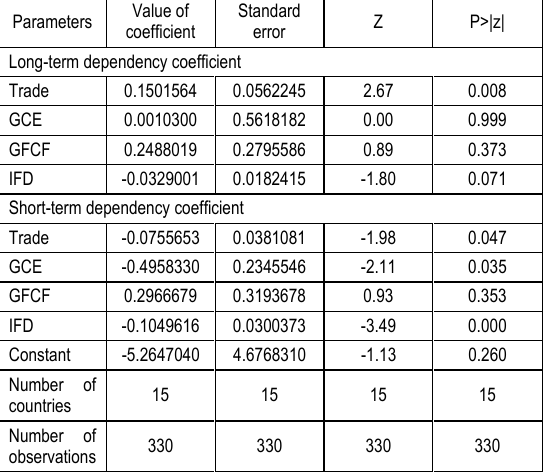
Table 11. The results of DFE approach to the